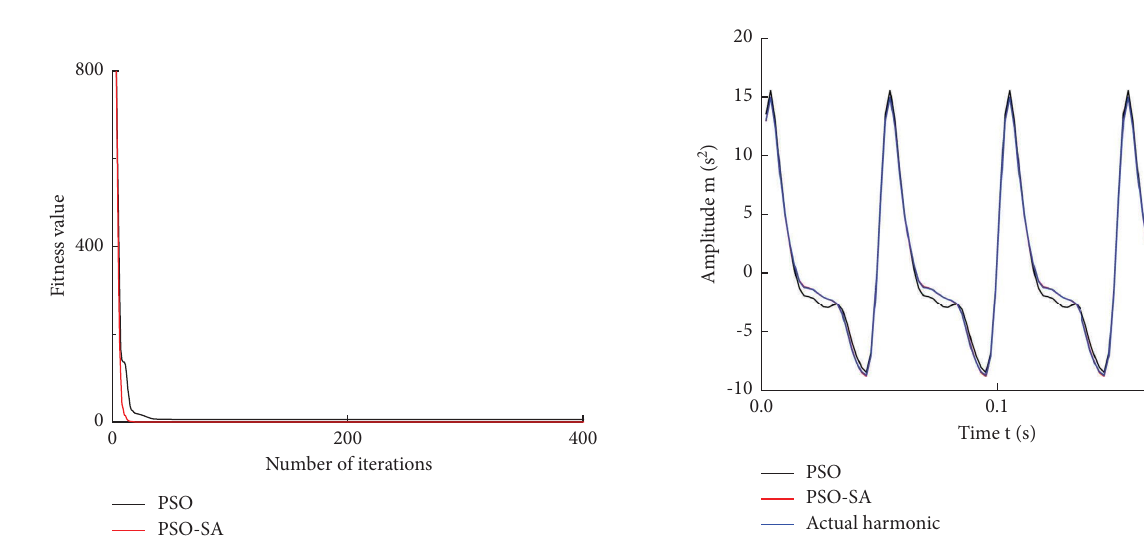
Figure 7: Relationship curve between ftness value harmonics and iteration times.